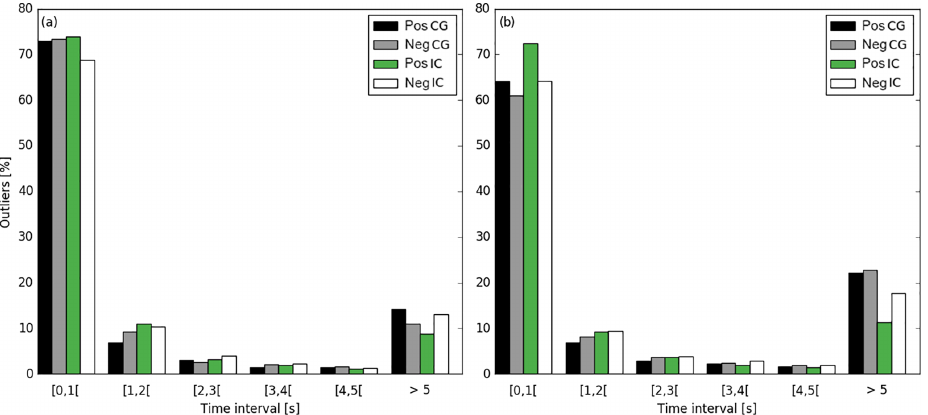
Figure 11. Distribution of the time difference between the outliers and their closest (in time) correctly located event in (a) Belgium and (b)